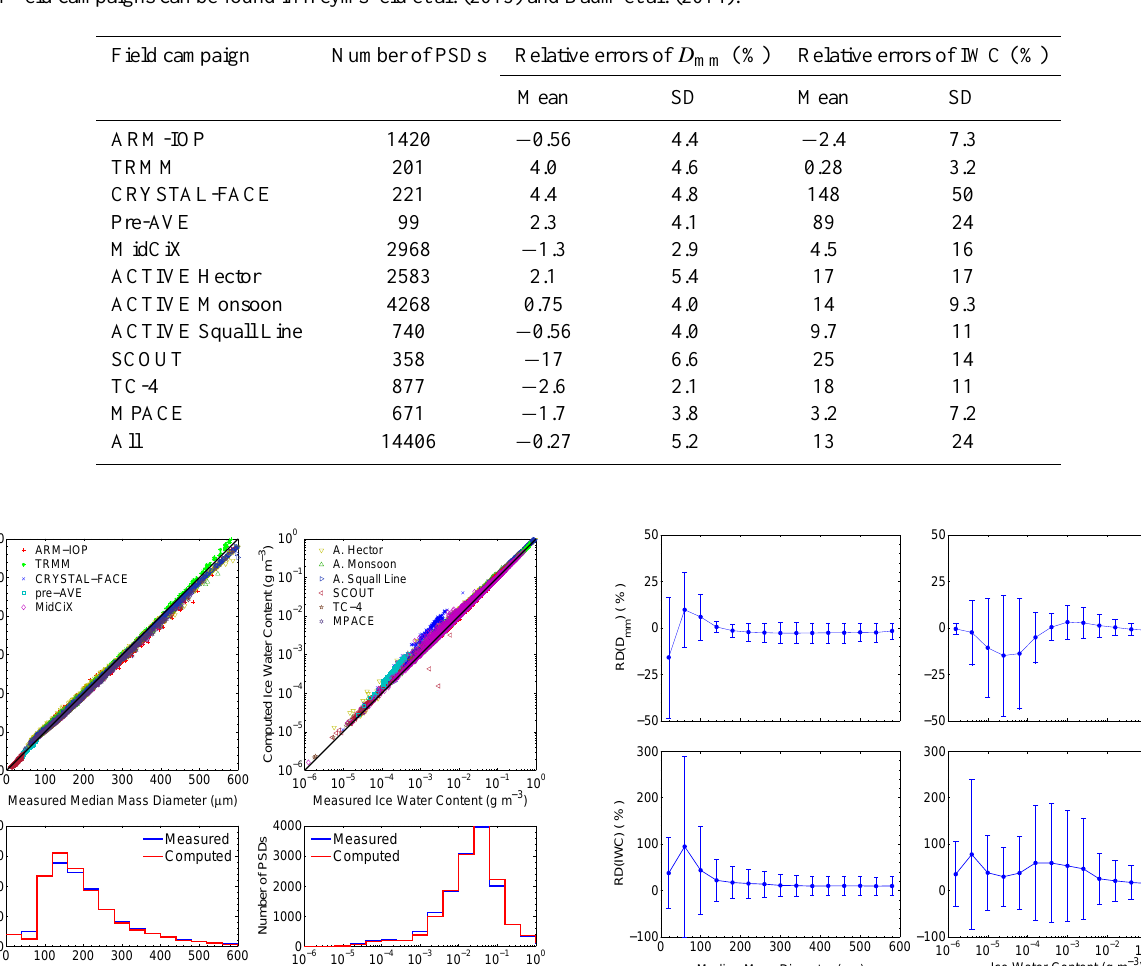
Table 1. Relative errors of the THM in representing the microphysical properties obtained during 11 field campaigns. The mean and standard deviation (SD) of the relative errors of the theoretical median mass diameter ( D mm ) and ice water content (IWC) are listed. The details of the 11 field campaigns can be found in Heymsfield et al. (2013) and Baum et al. (2014).